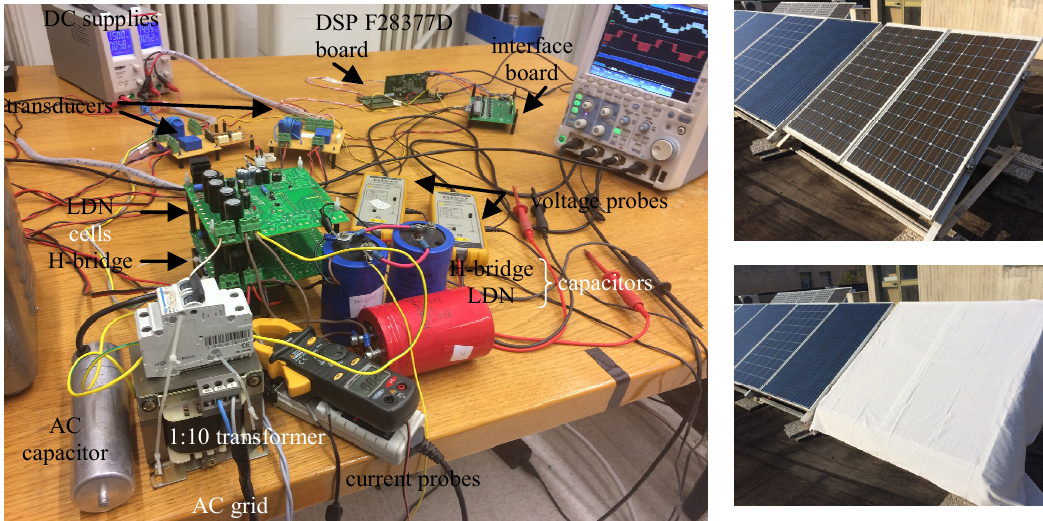
Figure 16. Picture view of the experimental setup in the lab ( left side) and arrangement of the PV array (two modules) on the roof, free and shadowed by a white sheet ( ≅ 500 W/m 2 and 200 W/m 2 , right side).